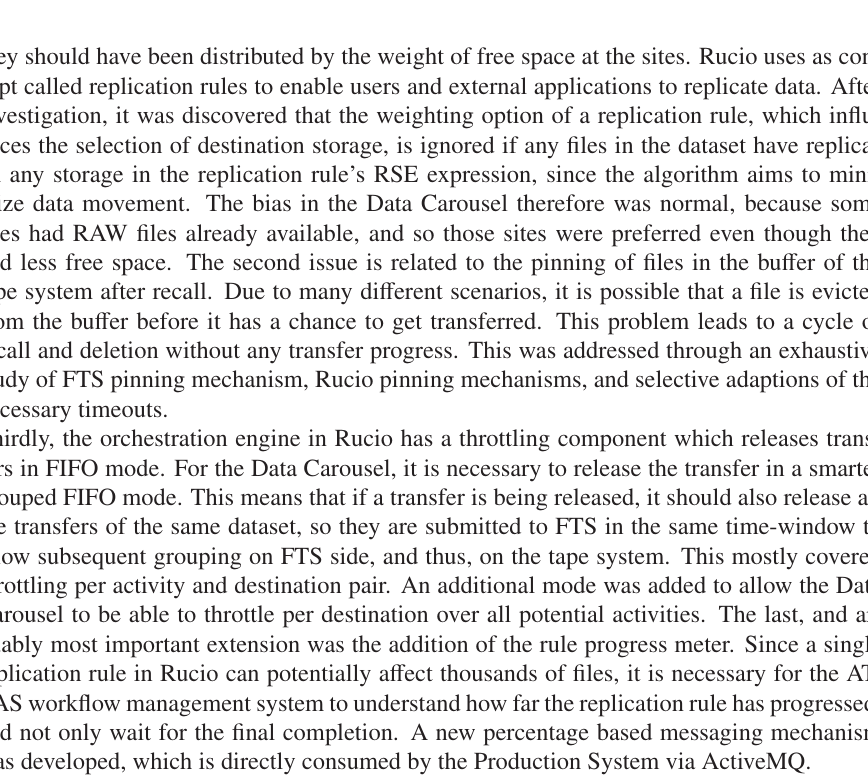
Figure 4: Data Carousel with